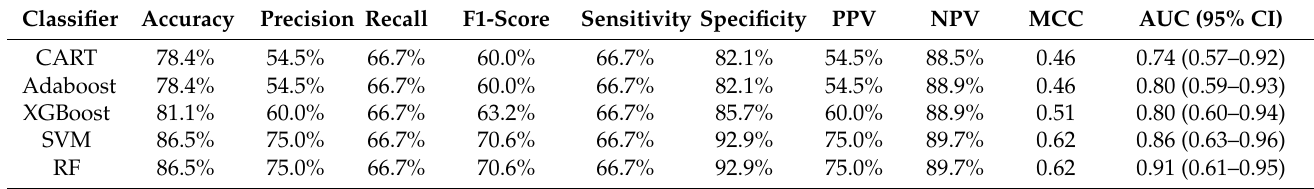
Table 2. Predictive performance matrix of five machine learning models.